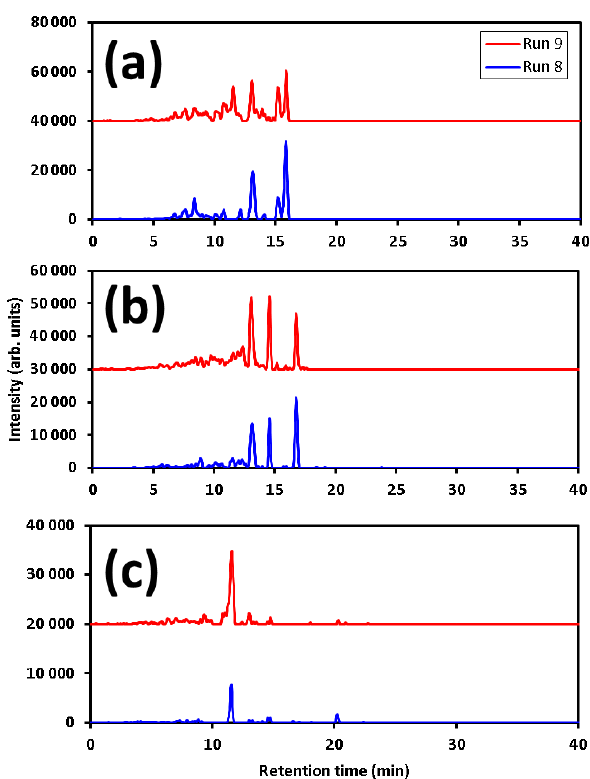
Figure 2. Extracted ion chromatograms of (a) C 10 H 16 O 5 Na + , (b) C 10 H 16 O 6 Na + , and (c) C 10 H 16 O 7 Na + formed by the addi- tion of sodium ion during the electrospray ionization of highly oxy- genated molecules present in fresh (run 8) and aged SOA particles (run 9).